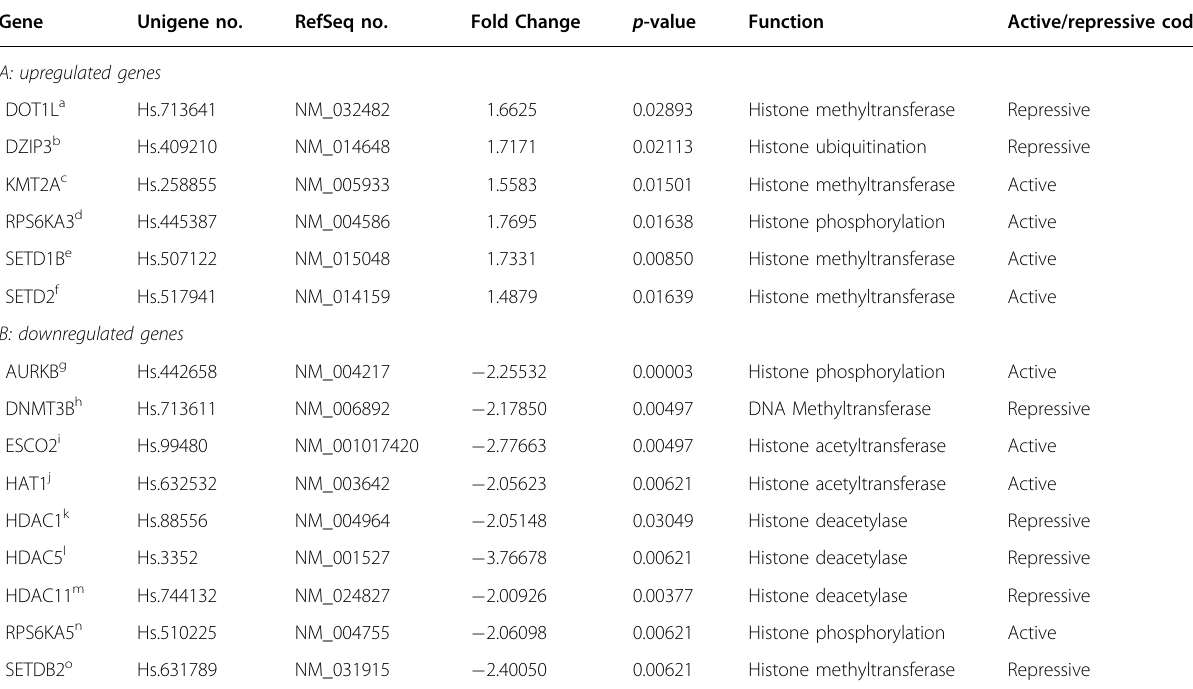
Table 1 Dysregulated genes in HCT116 p21 – / – cells compared to HCT116 WT cells. Gene Unigene no. RefSeq